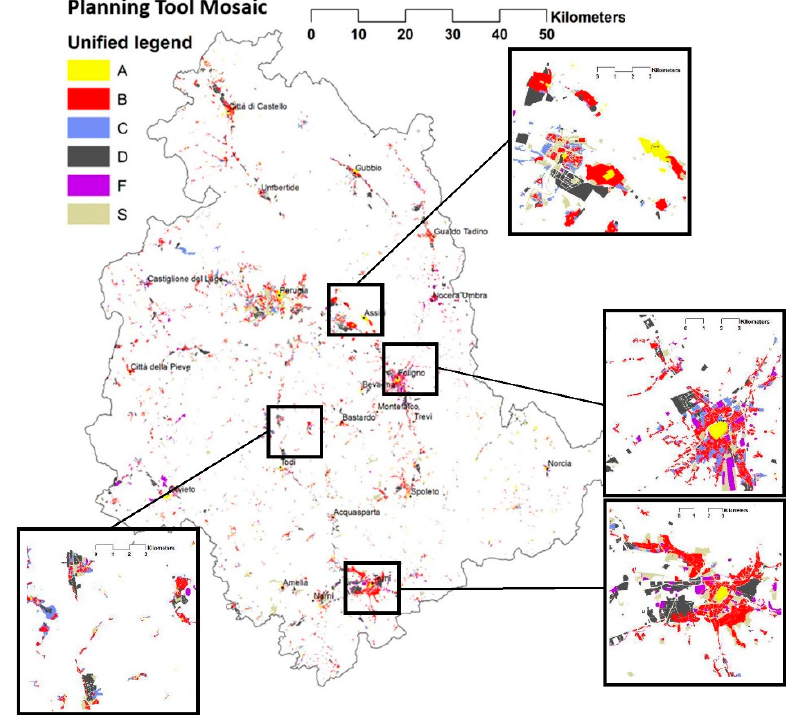
Figure 12. PTM of the Umbria region with unified legend (Ref. Ministerial Decree 1444/68).